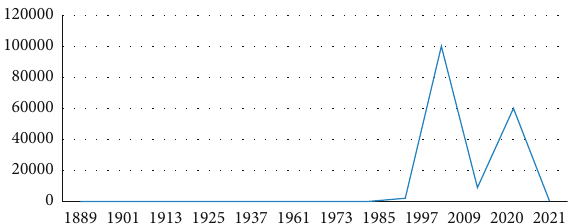
Figure 9: Article distribution by years for systematic review articles.